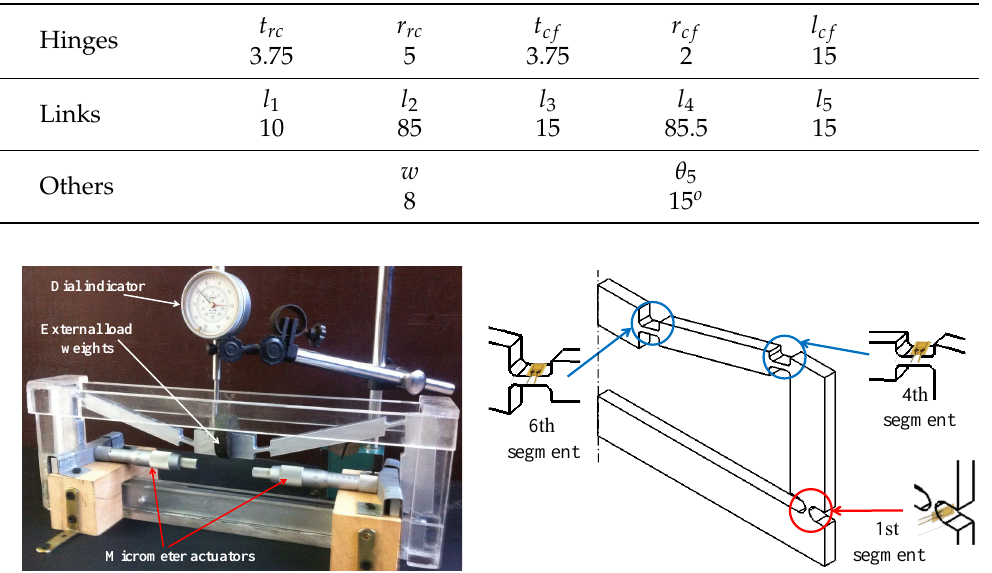
Figure 4. Experimental validation setup showing the locations of strain gauges on the